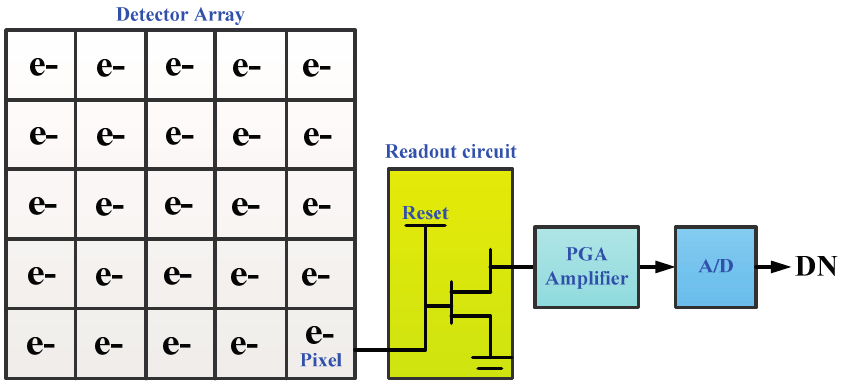
Figure 5. The sketch of detector and electronics